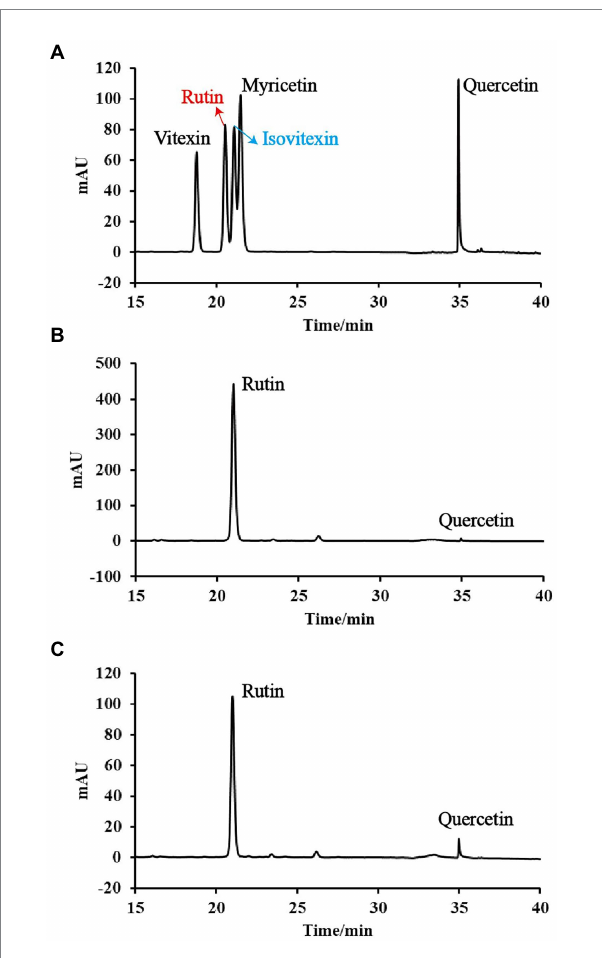
FIGURE 2 HPLC profiles of different instant powder samples: (A) standards; (B) instant powder obtained with individual extrusion; and (C) instant powder obtained with mixing